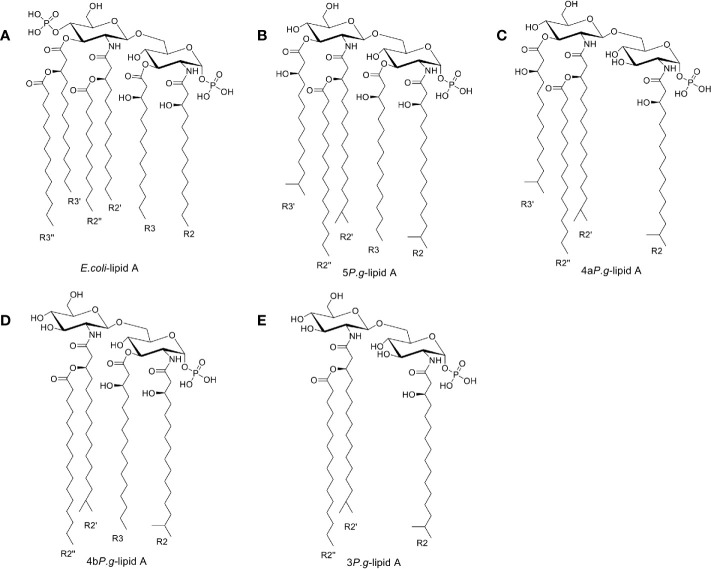
Chemical structures of Lipid A. (A) Lipid A structure found in E. coli-LPS. (B–E). Three lipid A species found in the LPS preparation of P. gingivalis (Dixon and Darveau, 2005) containing 5, 4, or 3 fatty acids, named as 5P. g-lipid A, 4aP. g-lipid A, 4bP. g-lipid A, and 3P. g-lipid A, respectively. The majority of bacterial lipid A structures are conserved and serve as the hydrophobic anchor of LPS on the majority of bacterial outer membranes.